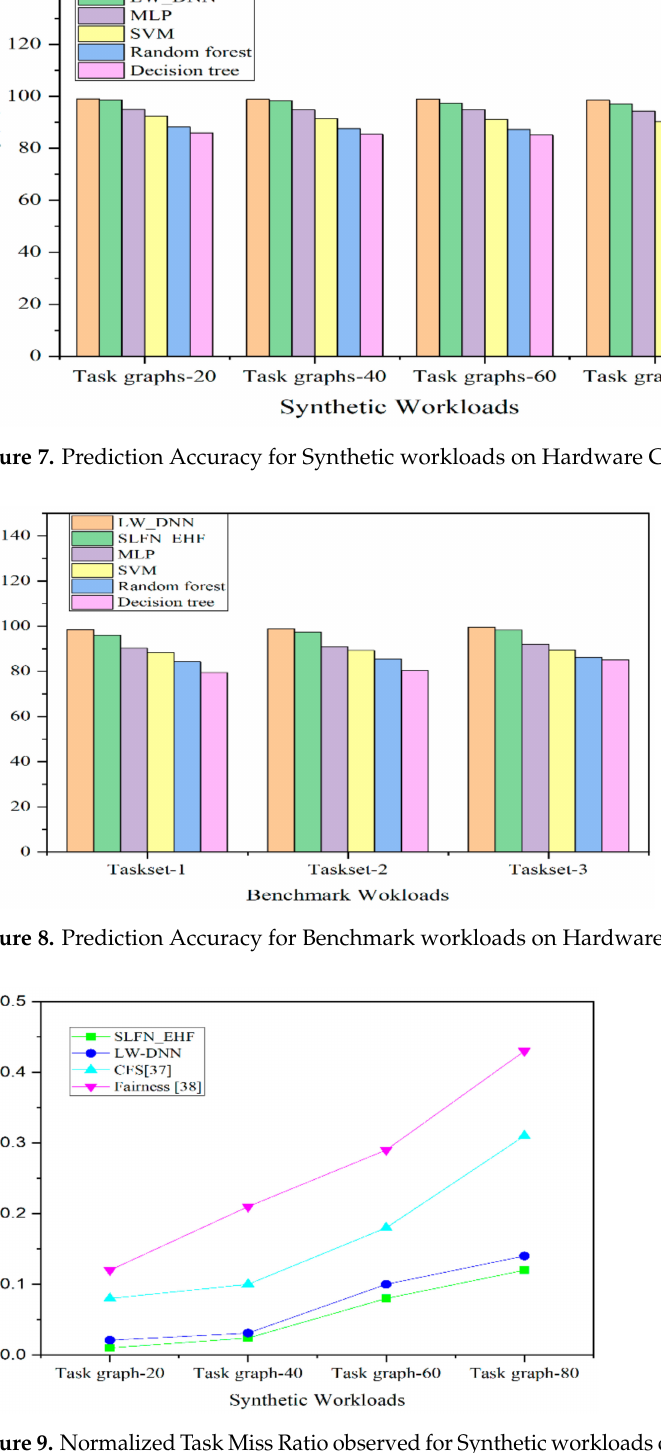
Figure 9. Normalized Task Miss Ratio observed for Synthetic workloads on Hardware Configuration 1. Figure 10 depicts the task miss instance rate on hardware configuration 1 for CAV and IoMT benchmark workloads. SLFN_EHF and LW_DNN task schedulers are optimized the TMR compared to the traditional